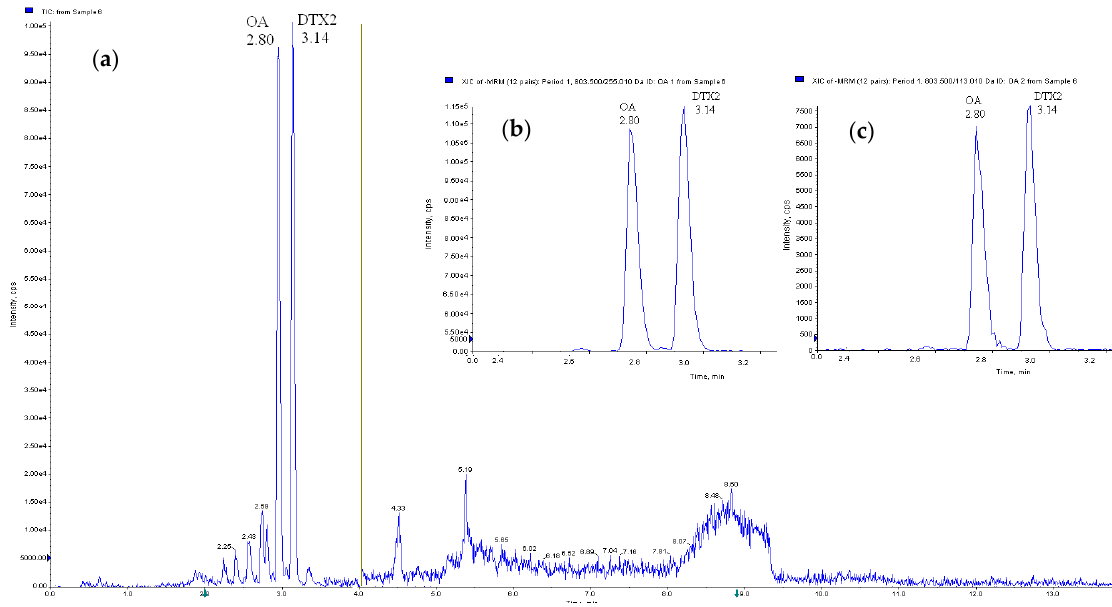
Figure 4. ( a ) Chromatographic profile of toxins in a mussel sample from Tortolì containing OA and DTX2 with primary ( b ) and secondary ( c ) MRM peaks obtained after LC-MS/MS analysis.